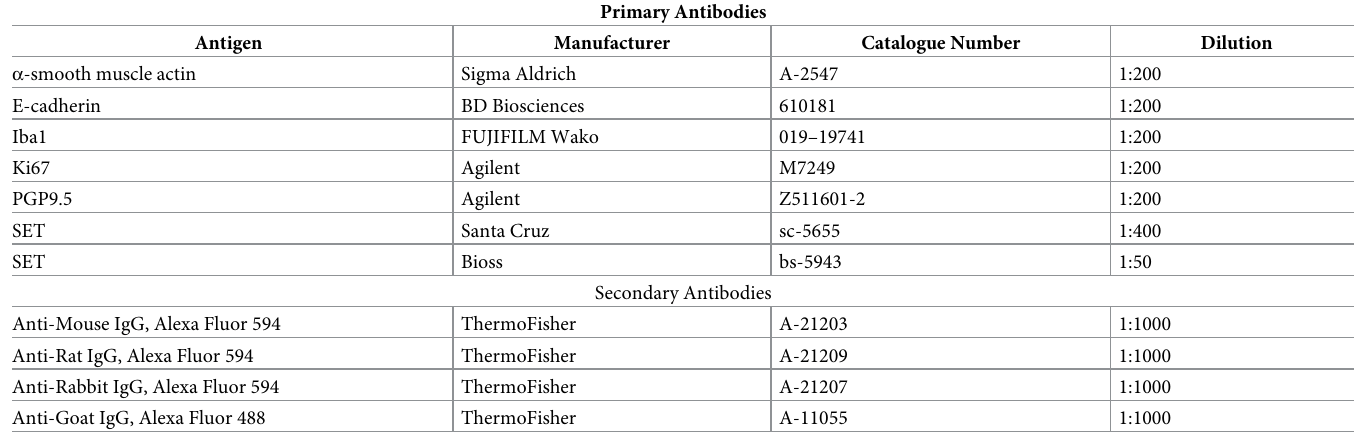
Table 1. List of antibodies used in this